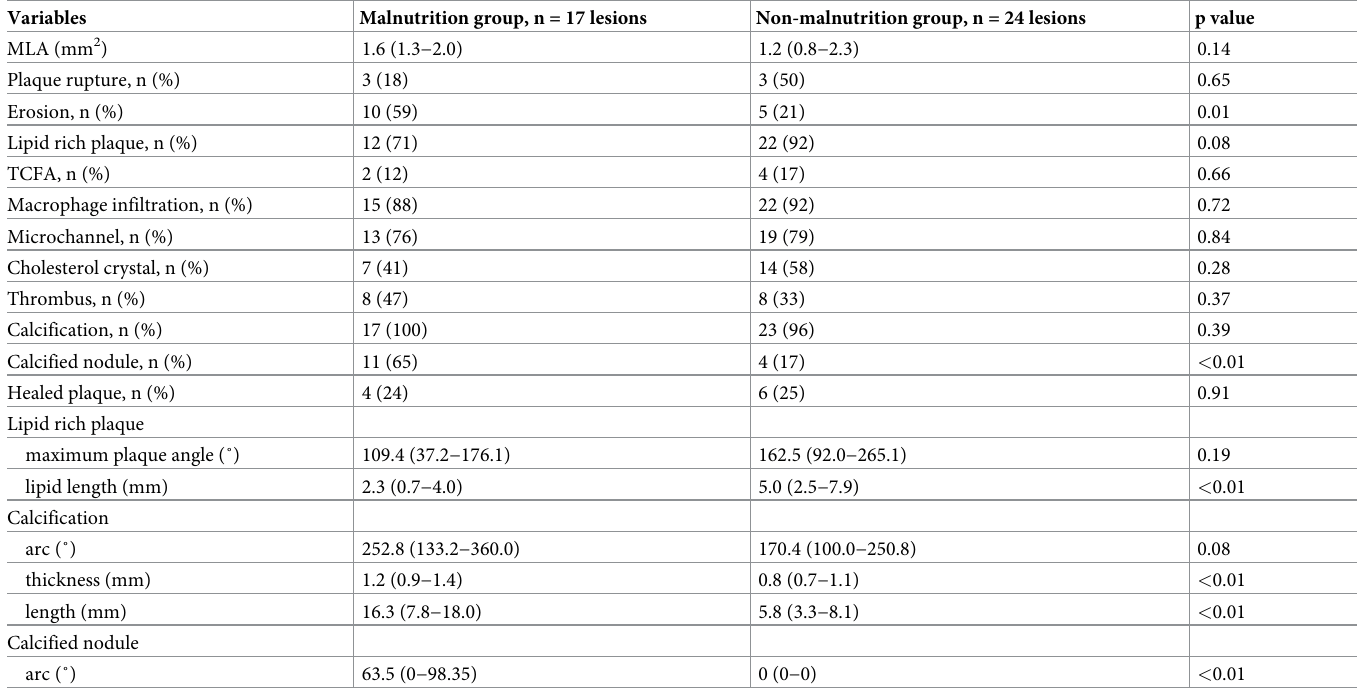
We evaluated the neointima in the culprit lesions after stenting. We compared 11 lesions of the malnutrition group with 14 lesions of the non-malnutrition group (Table 4). Among the neoatherosclerosis cases, only the presence of thrombus was significantly more common in the malnutrition group. Although the groups showed no significant differences, the frequency of calcification tended to be higher in the malnutrition group. We compared the non-culprit lesions between the two groups by considering 17 and 22 lesions in the malnutrition and non- malnutrition groups, respectively (Table 5). Plaque quantification was determined at baseline and at 6 months. At each time point, lipid plaques tended to be larger in the non-malnutrition Table 2. Baseline pre-PCI OCT findings of the culprit